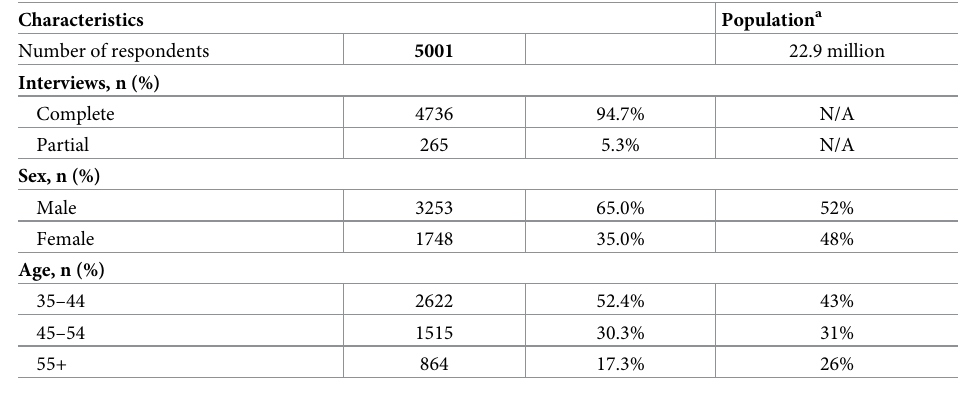
Table 4. Respondent demographics: Sri Lanka COVID-19